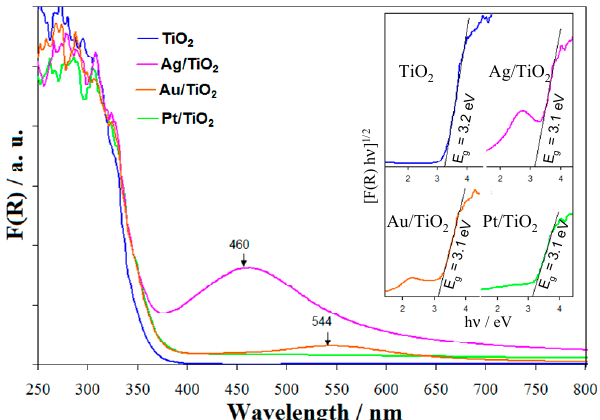
Figure 2. Comparative F(R) spectra and indirect optical band gap derived from Tauc representation (inset) for investigated photocatalysts.